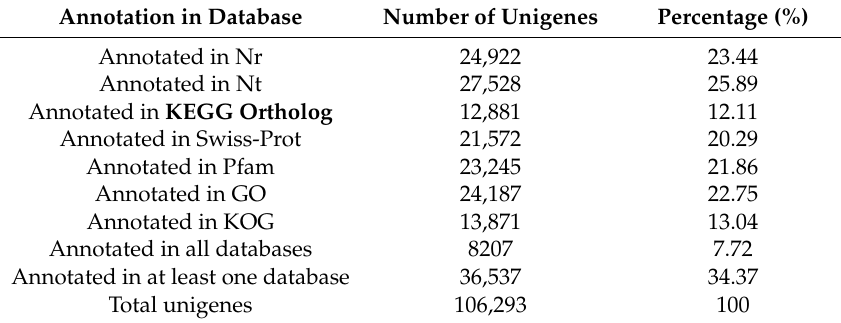
Table 3. BLAST analysis of non-redundant unigenes against seven different databases.